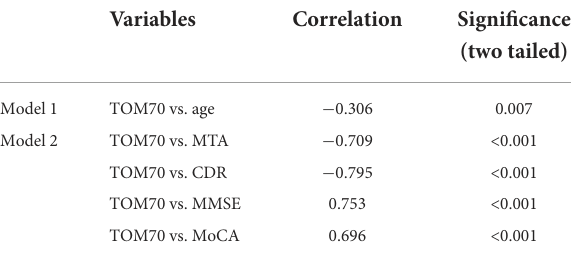
TABLE 3 Partial correlation between TOM70 and